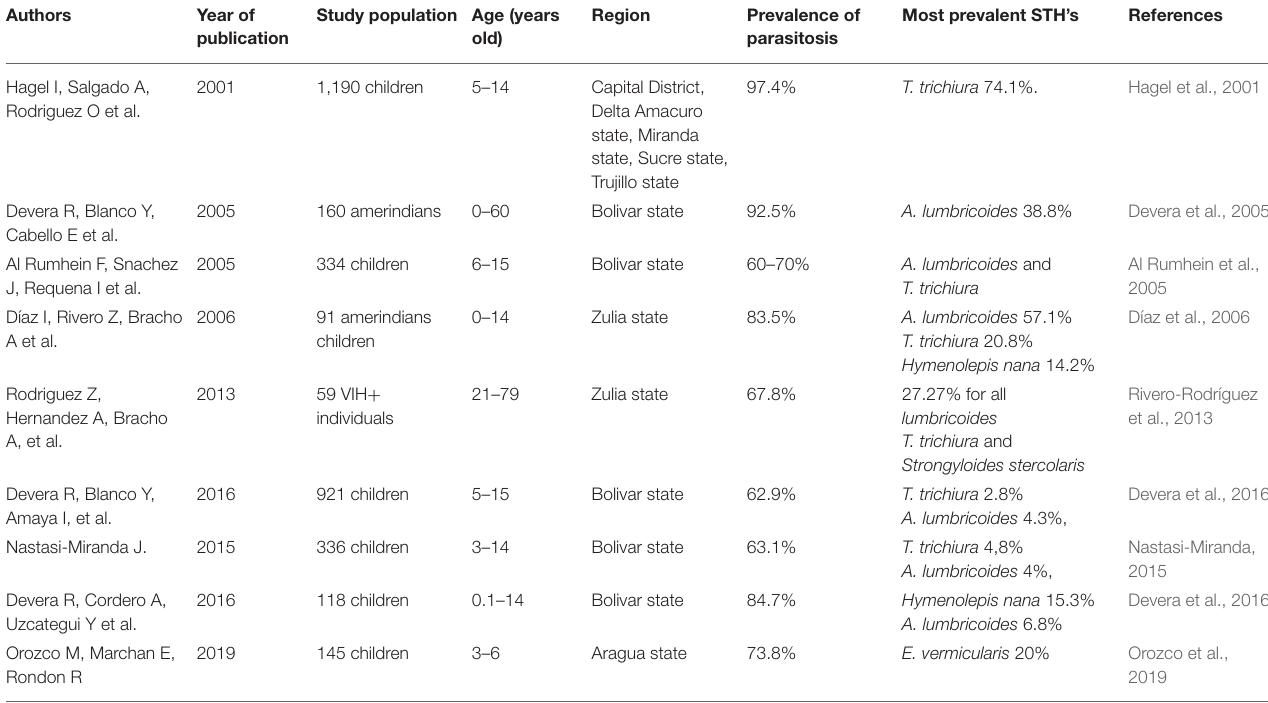
TABLE 2 | Parasitoses prevalence studies in Venezuela between 2001 and 2018.